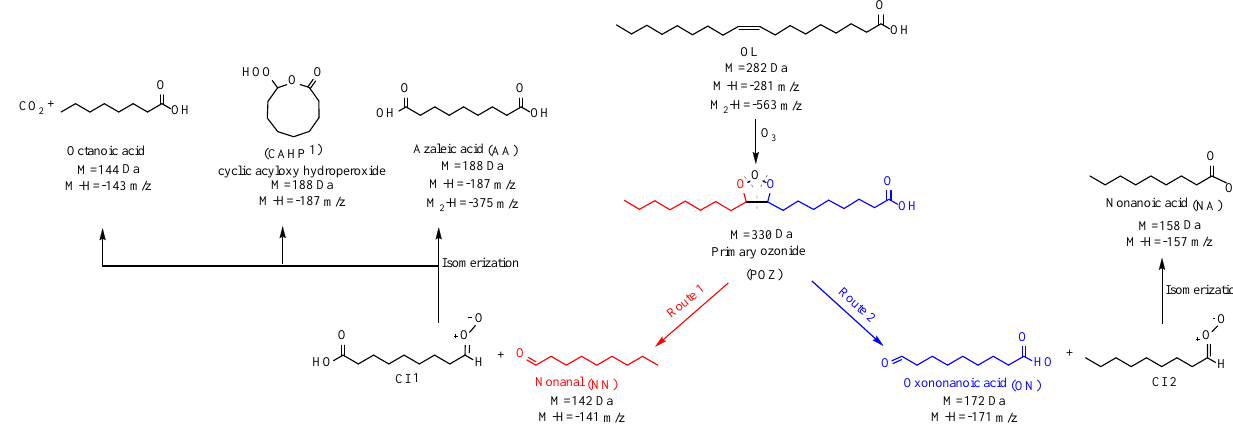
a (plug flow) residence time of 135 s. In some experiments a nitrogen flow was used to generate the aerosol (via homo- geneous nucleation of OL); in these cases a small flow of oxygen was added to ensure the air composition within the AFT had an atmospheric N 2 : O 2 ratio. Constant gas flows were achieved using calibrated mass flow controllers. The Reynolds number for the AFT was 13.1 and hence flow within the reactor was predicted to lie firmly within the lam-